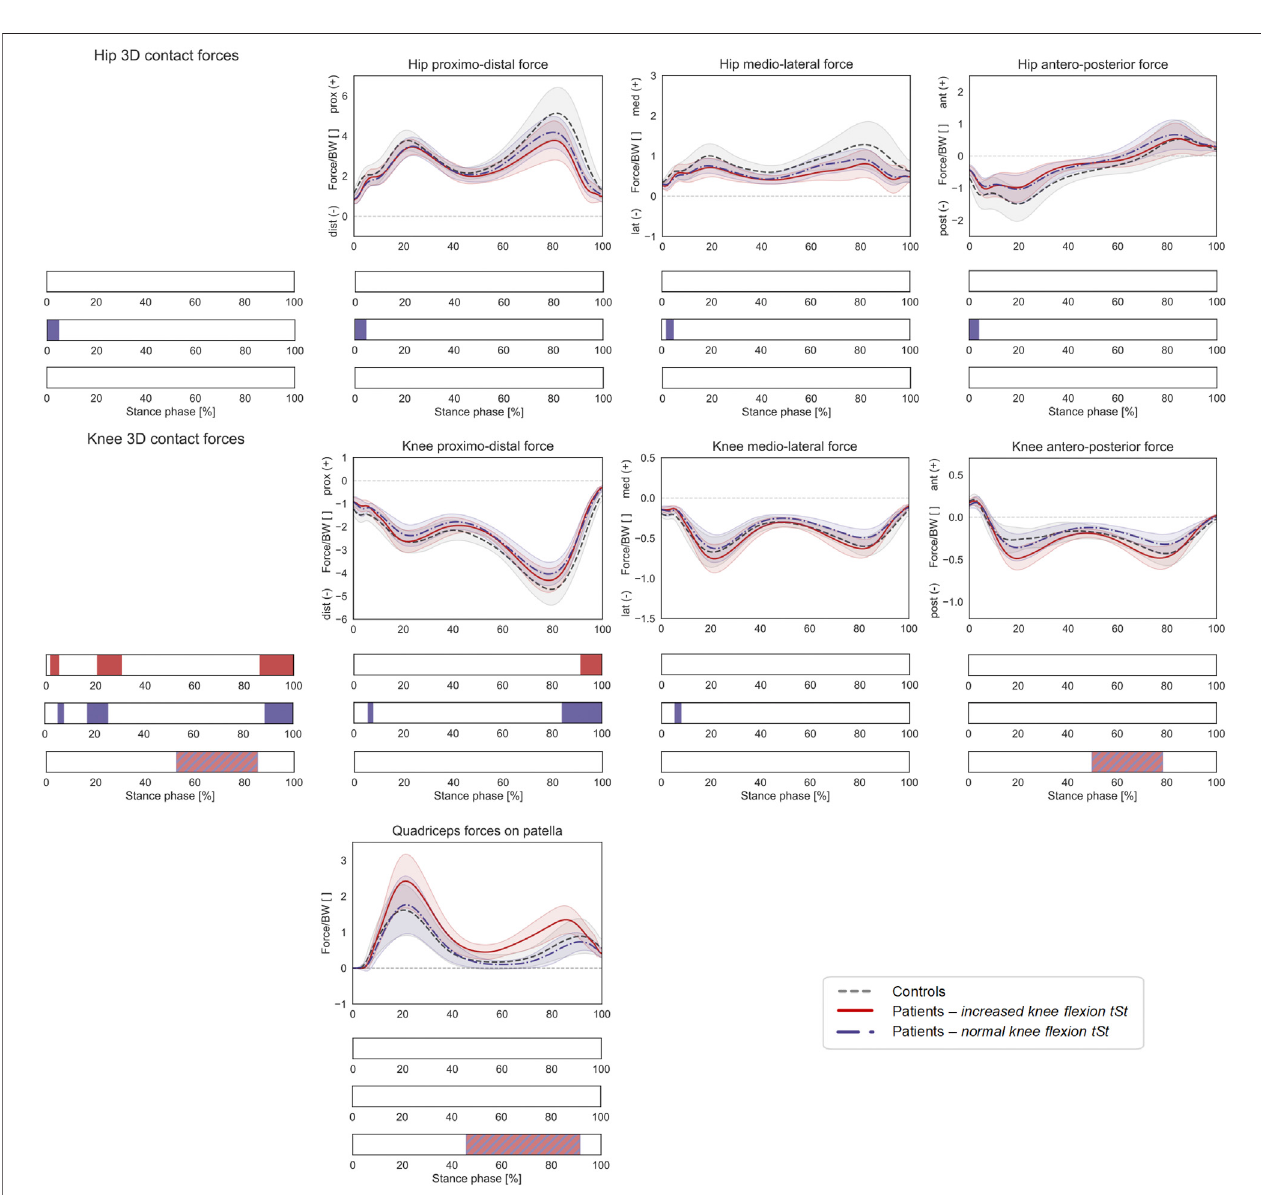
FIGURE 7 | Joint forces during stance phase (ST) with patient strati fi cation according to knee fl exion angle during terminal stance (KneeFlex tSt ). Mean ± 1SD hip and knee proximo-distal, medio-lateral, and antero-posterior contact forces,aswell asresultantforce exertedbythequadricepsmusclesonthepatella, arereportedas grey dashed lines forcontrols, asred solidlinesfor patients withincreased KneeFlex tSt ,and asblue dashed-dottedlines for patients with normal KneeFlex tSt .Intervalsof ST with a statistically signi fi cant difference in the relevant SPM tests are reported as red bars for the comparison between controls and patients with increased KneeFlex tSt , as blue bars for the comparison between controls and patients with normal KneeFlex tSt , and as red-and-blue striped bars for the comparison between patients with increased vs. normal KneeFlex tSt . Knee and hip contact forceswere regarded as a3D vector fi elds. 3-dimensional signi fi cant differences between patients and controls were analyzed by means of two-sample Hotelling T2 tests and are reported in the leftmost panels. The resultant force on the patella, as well as individual components of the vector fi elds in the post-hoc vectorial analyses, were analyzed by means of two-sample t-tests and intervals characterized by signi fi cant differences between the two groups are reported below each